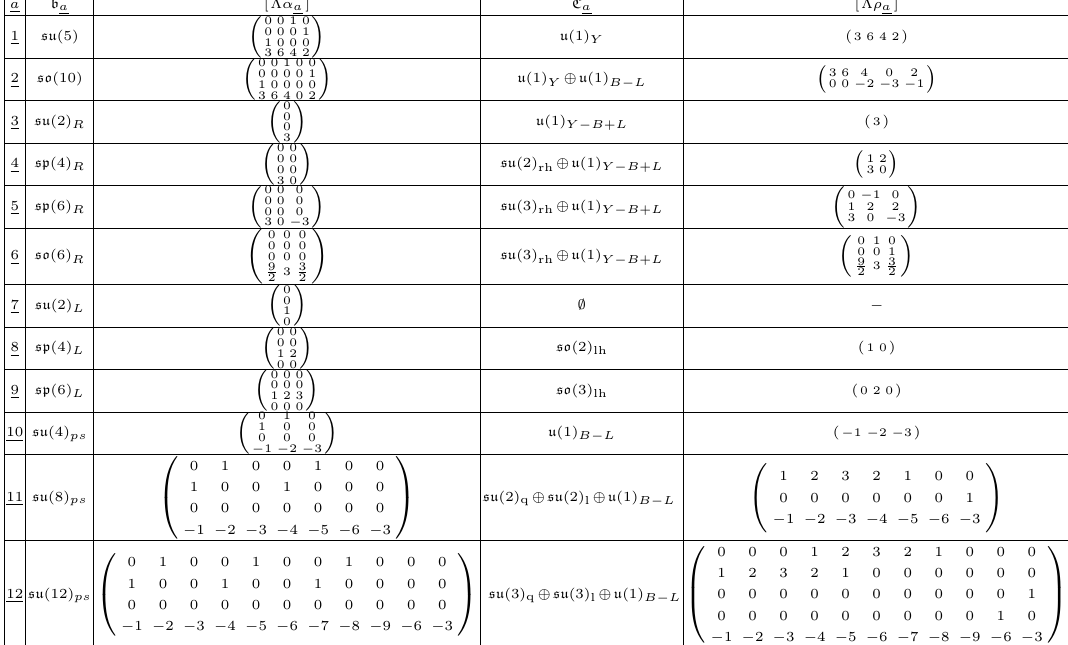
Table 2 . A set of building blocks { b a } , where a ∈ { 1 , . . . , 12 } , from which all 27 maximal